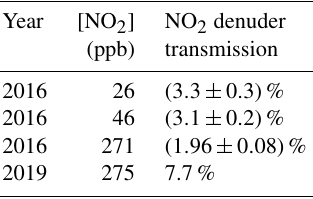
Table 2. Transmission of denuder at three concentrations of isobutyl nitrate (IBN) and one concentration of chamber-generated AN. Transmission is defined as the percentage of gas-phase alkyl nitrate that was passed through the denuder. Errors for the 2016 measure- ments are the standard deviation. Year AN source Concentration Transmission through (ppb)